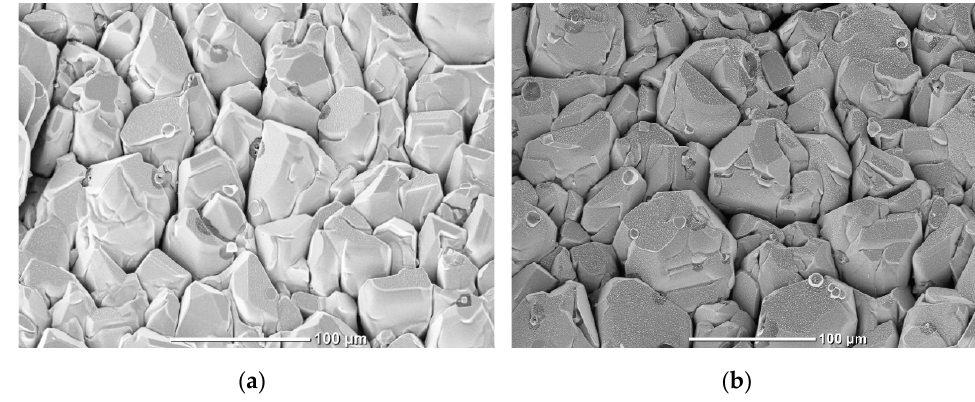
Figure 2. Planar SEM images of studied ZnO films (front side): ( a ) N1 film and ( b ) N2 film.